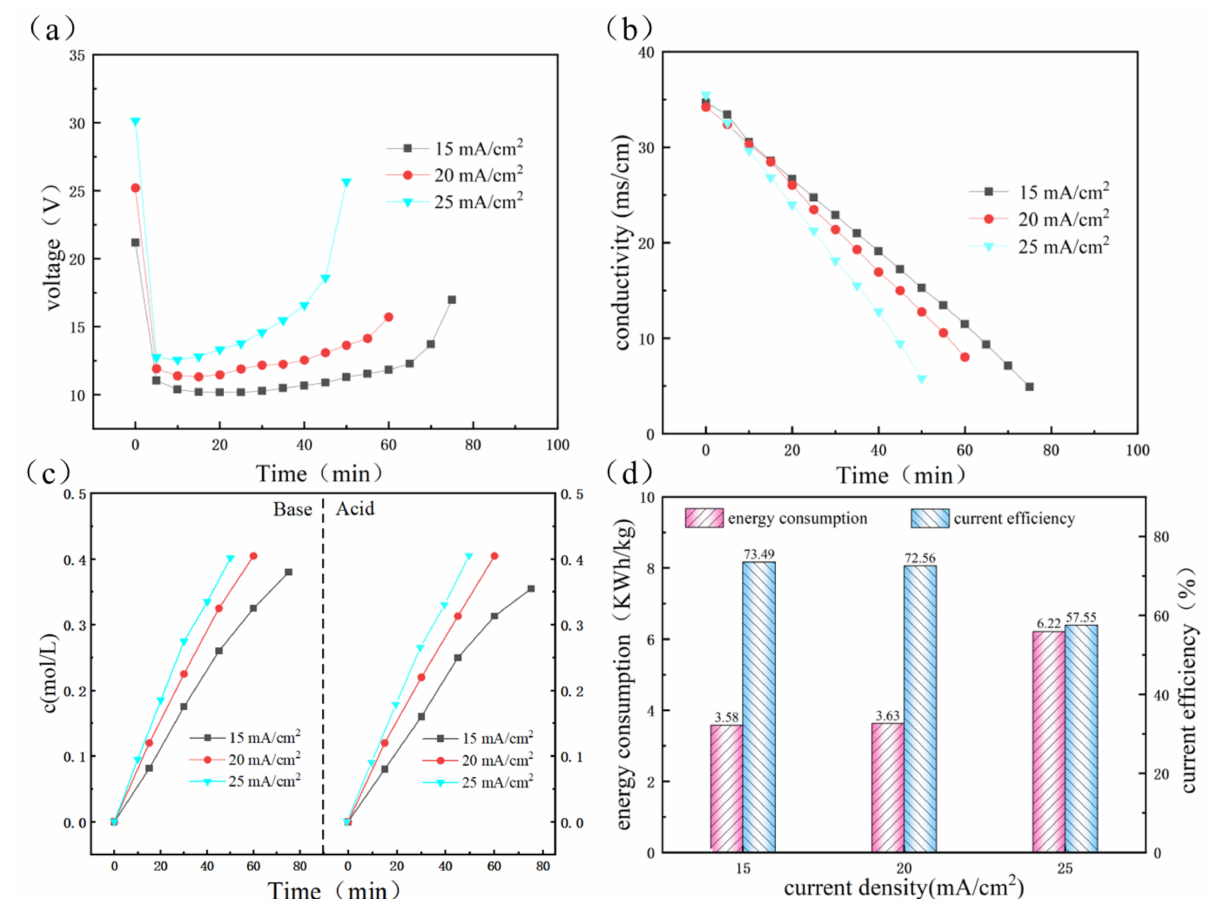
Figure 6. Effect of current density on ( a ) membrane stack voltage; ( b ) conductivity of feed compart- ment; ( c ) the concentrations of acid and base; ( d ) current efficiency and energy consumption. The feed conductivity: 35 mS/cm. Initial HCl and NaOH contents: 0 mol/L. flow velocity: 20